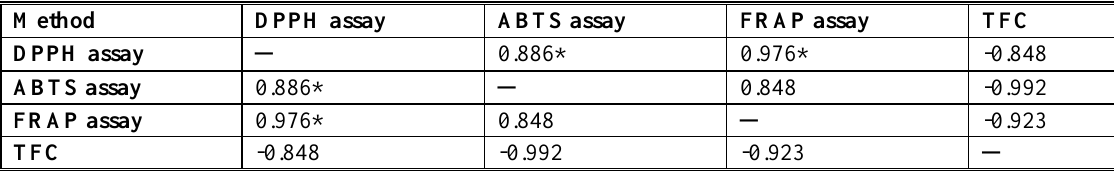
Table 6.The pearson's correlation coefficient